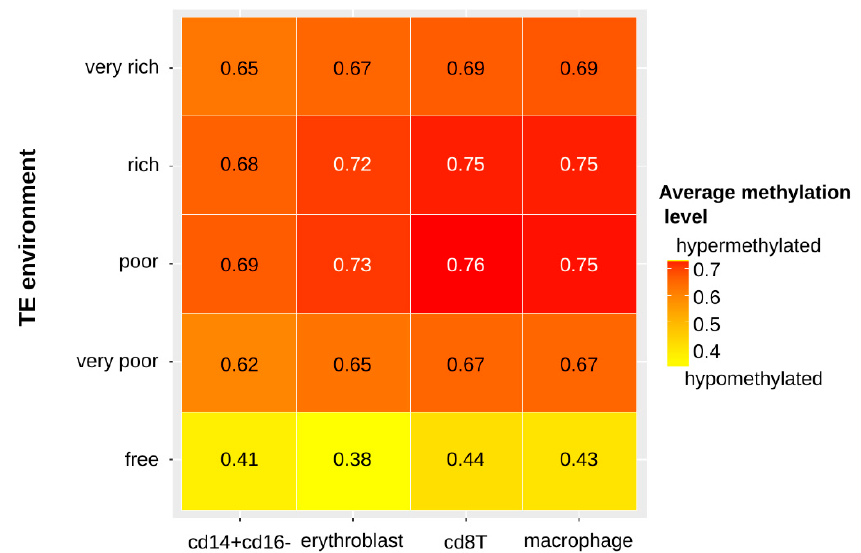
Figure 4. Average methylation level of the duplicated genes according to their neighborhood in TEs in the four cell types. (Kruskal-Wallis tests, p -values < 2.2 × 10 − 16 ).